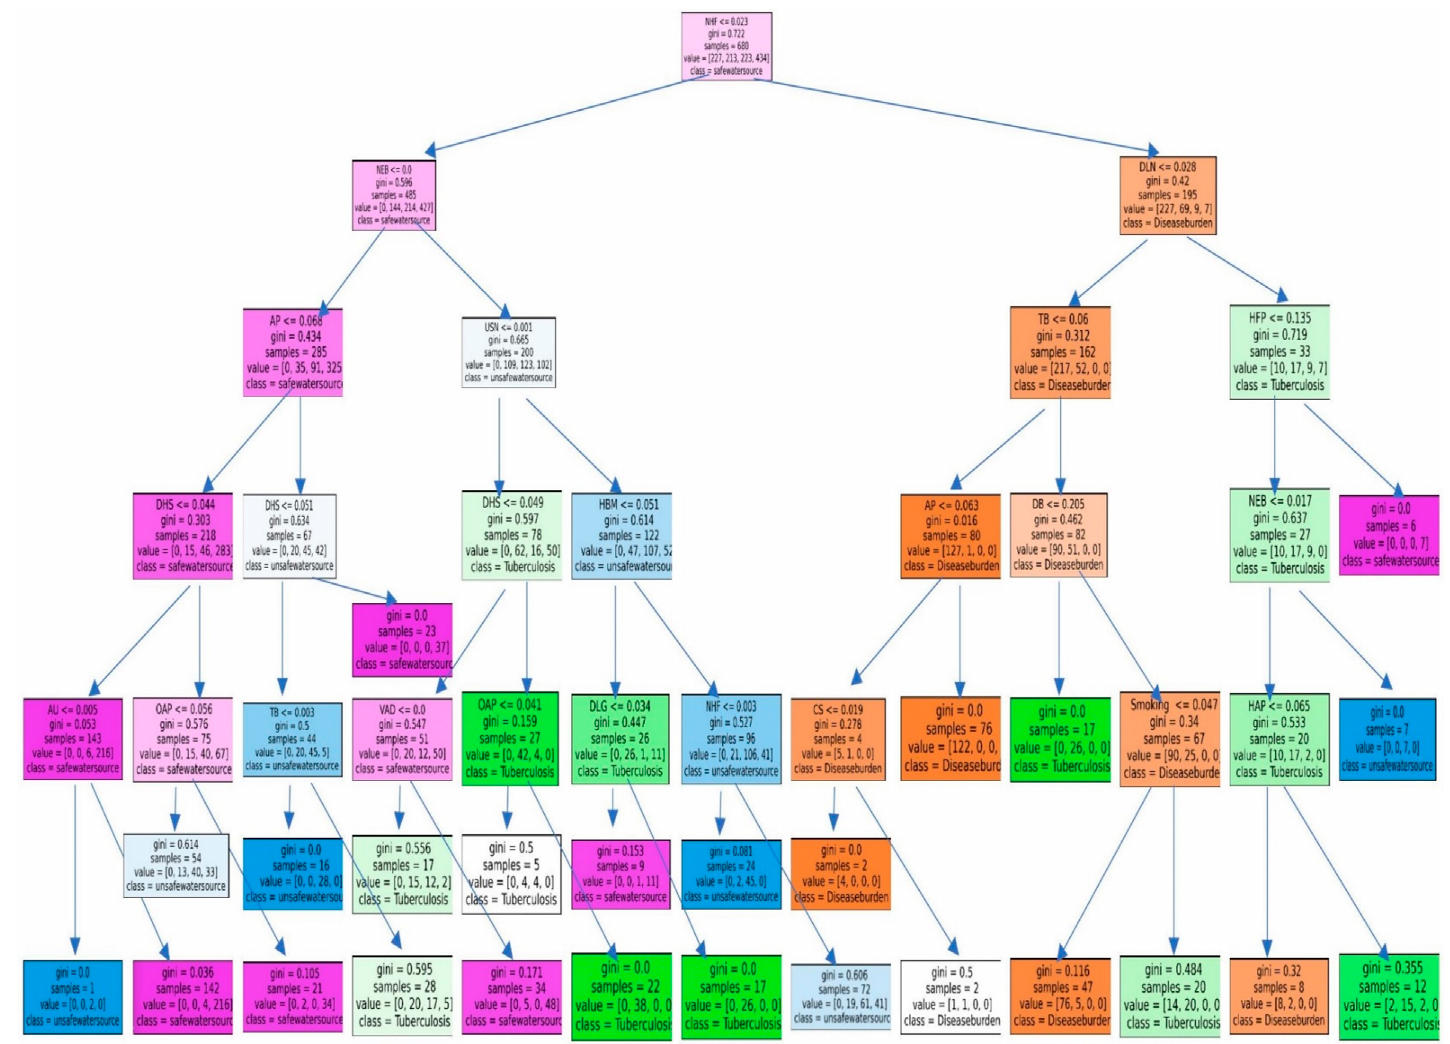
Figure 4. The tree structure of the RFM.